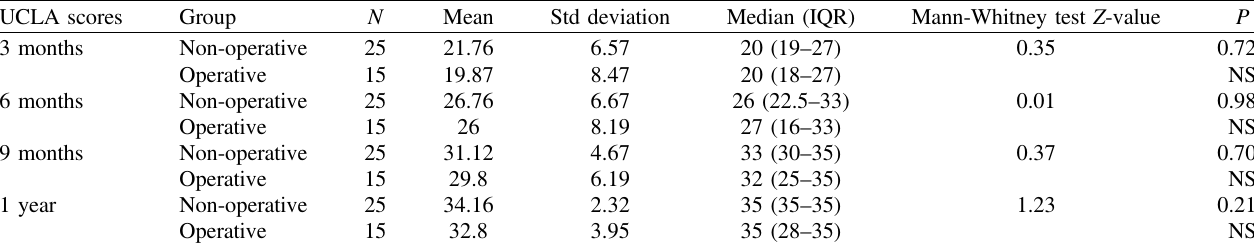
Table 3. Average UCLA scores at each follow-up.